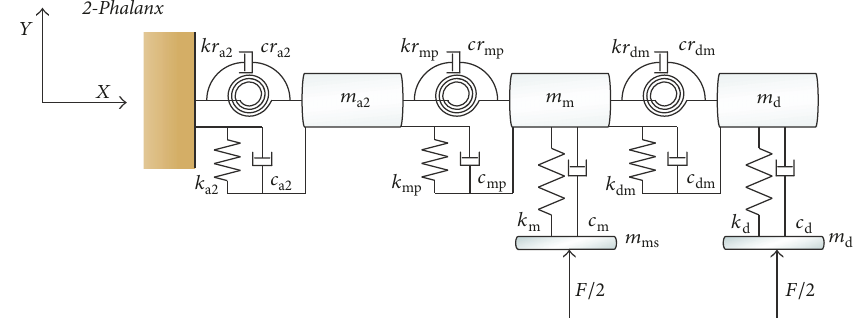
Figure 3: The model configuration used for the distal and middle finger phalanxes (denoted as 2-Phalanx).